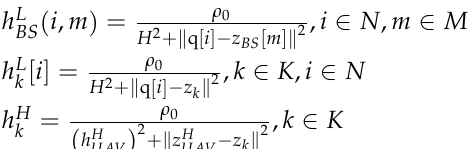
Table 1. Notations.